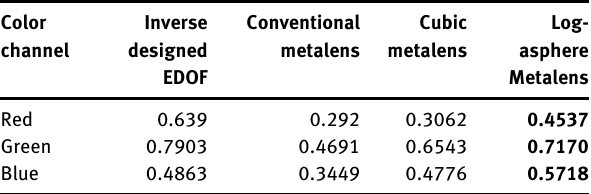
Table  : SSIM on simulation-restored images for standard and different EDOF